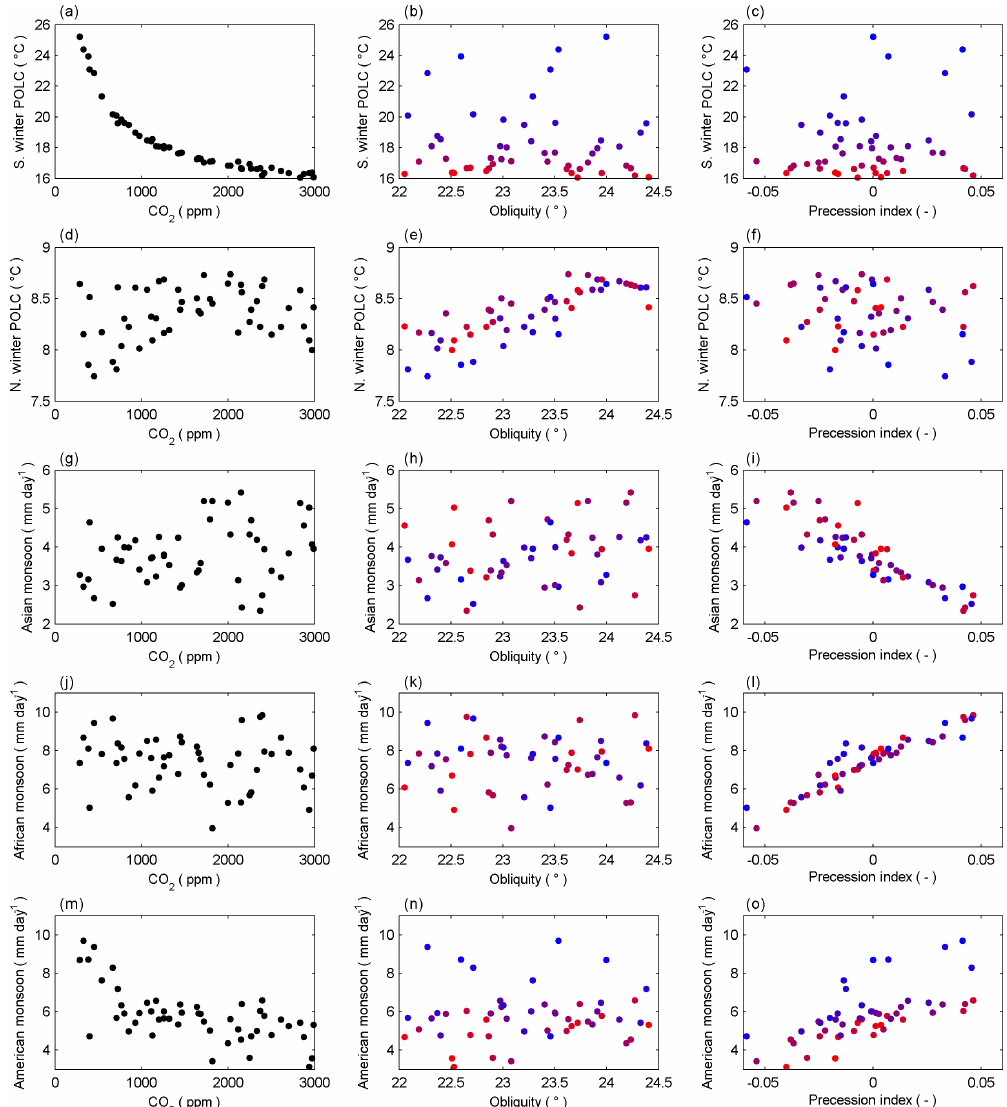
Figure 6. Correlation between three forcing factors (CO 2 , obliquity and precession index; in columns from left to right) and the simple metrics (southern winter polar OLC, northern winter polar OLC, Asian monsoon index, African monsoon index and the S. American – hereafter referred to as “American” – monsoon index; in rows from top to bottom). CO 2 is plotted in colour in the obliquity and precession plots (blue is low; red is